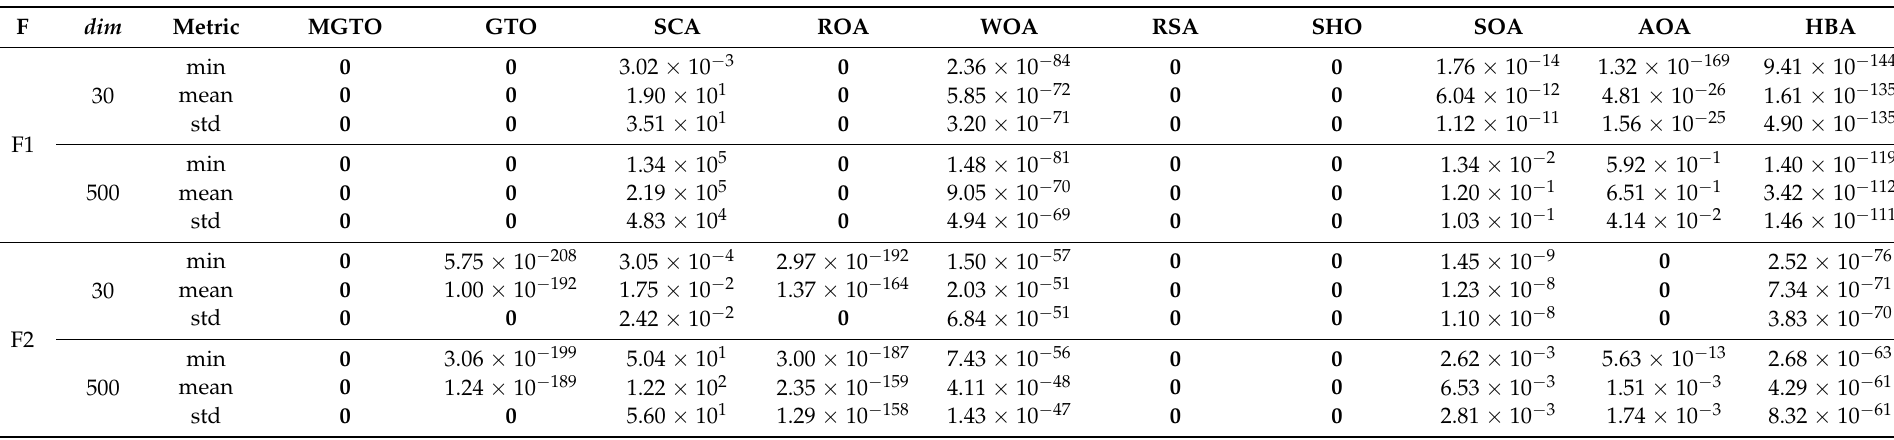
Table 3. Statistical results of 23 standard reference